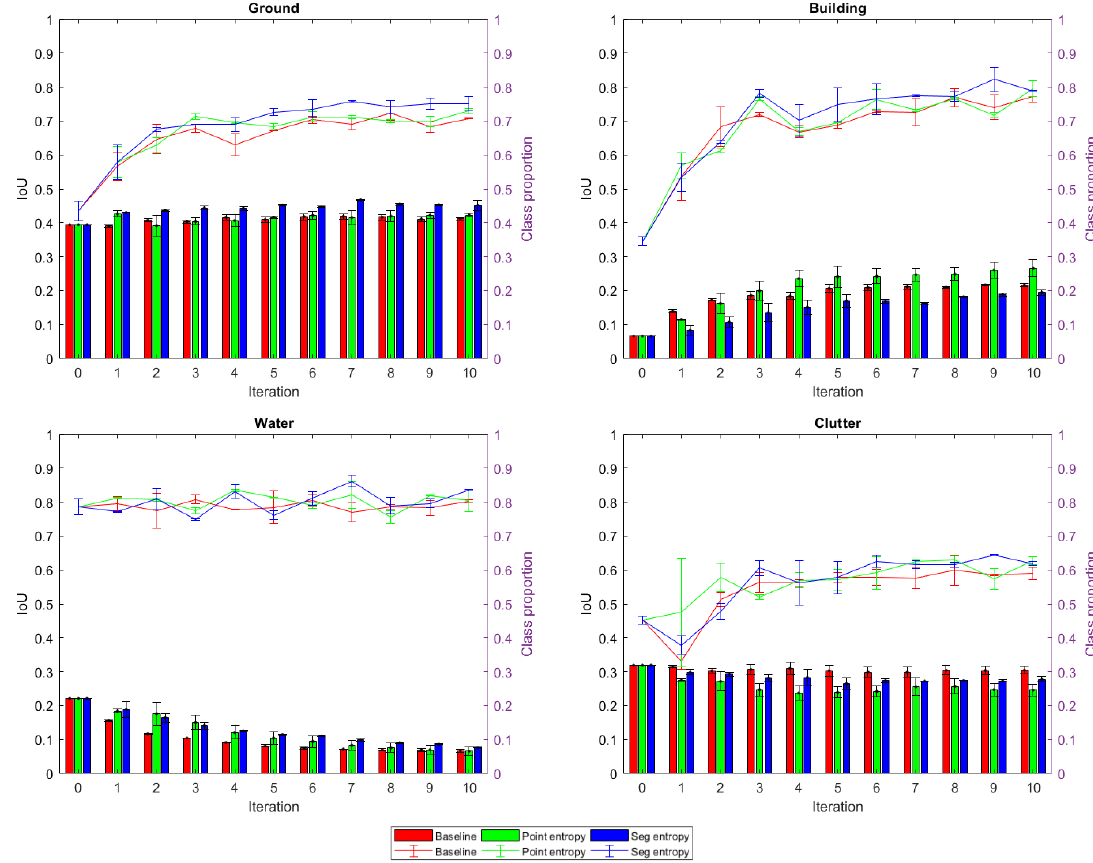
Figure 5. IoU (lines) and data distribution (columns) for different classes. The horizontal axis represents the iteration. Error bars represent standard deviation.